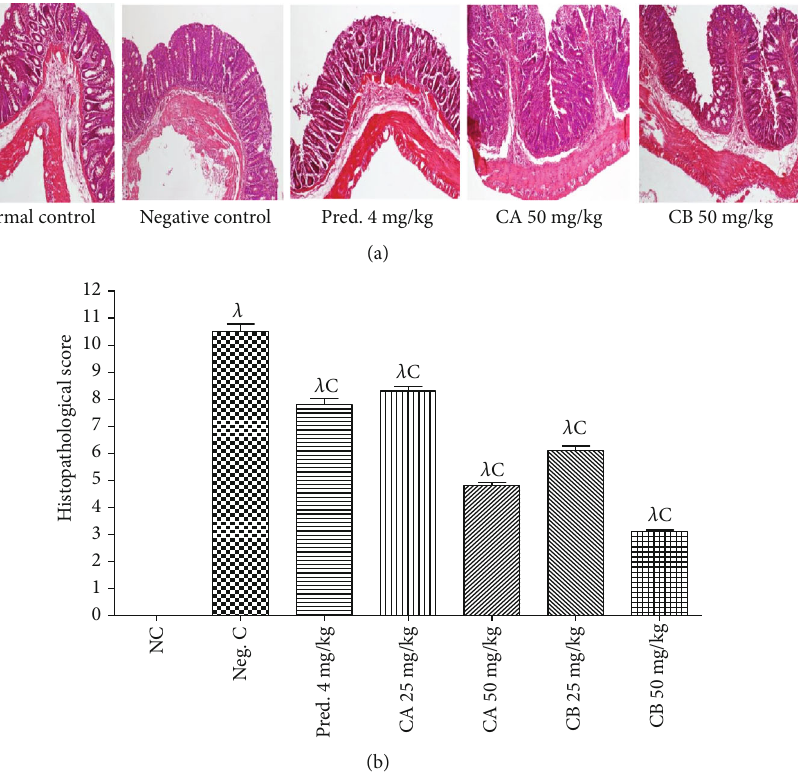
Figure 4: E ff ect of Combretin A and Combretin B on histopathological score in DSS-induced colitis in rat. (a) Representative hematoxylin and eosin (H&E)-stained distal colon sections and (b) the histologic scores of rats. Values are expressed as mean ± SEM for six animals and analyses by one-way ANOVA followed by the Tukey post hoc test; C p < 0 : 001 : signi fi cant di ff erence compared with negative control (Neg. C); λ p < 0 : 001 : signi fi cant di ff erence compared with normal control (NC). CA: Combretin A; CB: Combretin